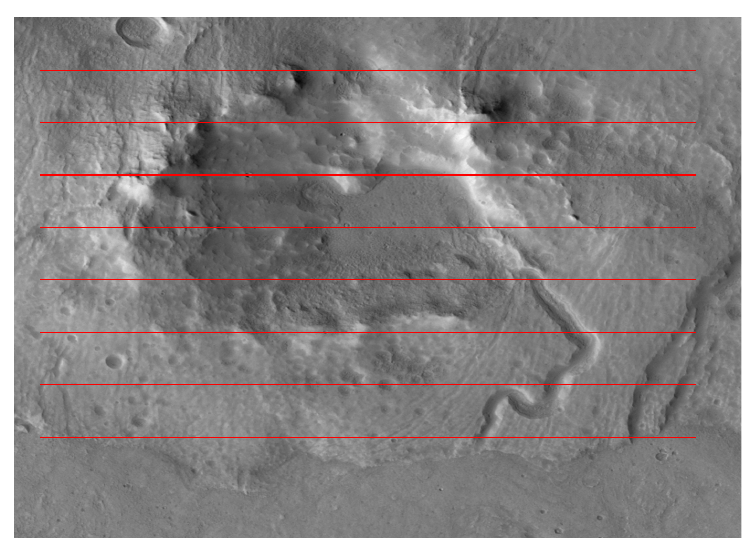
Figure A1. Profiles selected for the Bayesian optimization to determine the atmospheric parameters and the mean albedo.